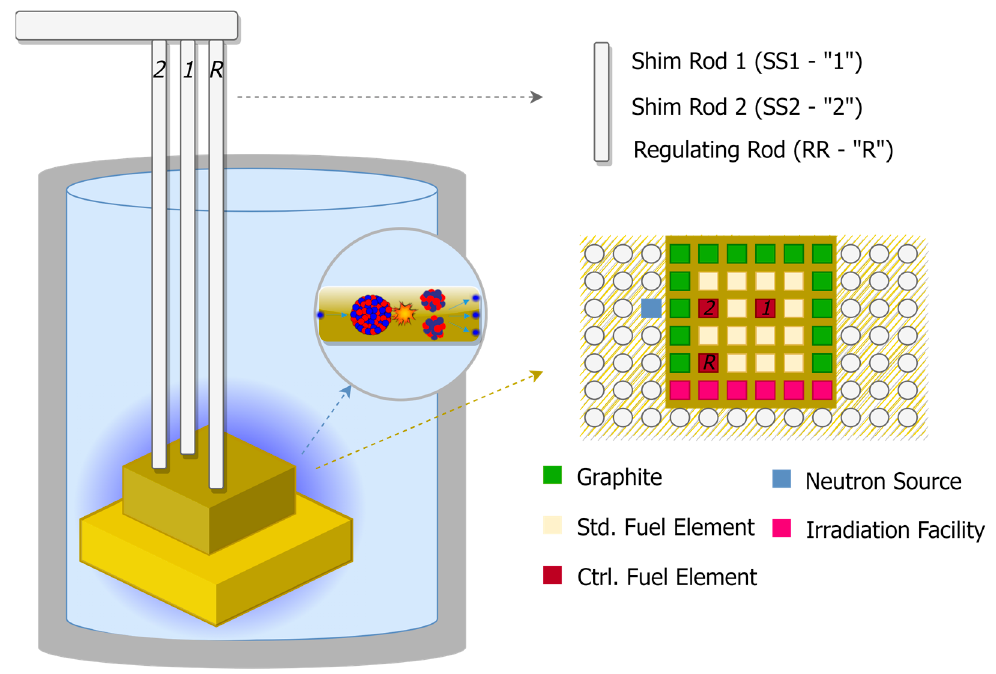
Figure 3. Schematics of PUR-1. From PUR-1 benchmarks, 𝛬 = 8.13 ∙ 10 (cid:2879)(cid:2873) s and 𝑆 (cid:2868) = 10 (cid:2875) n/cm 2 ·s. The values of 𝑛 = 7 × 10 (cid:2872) n/cm 2 ·s. (cid:2868)